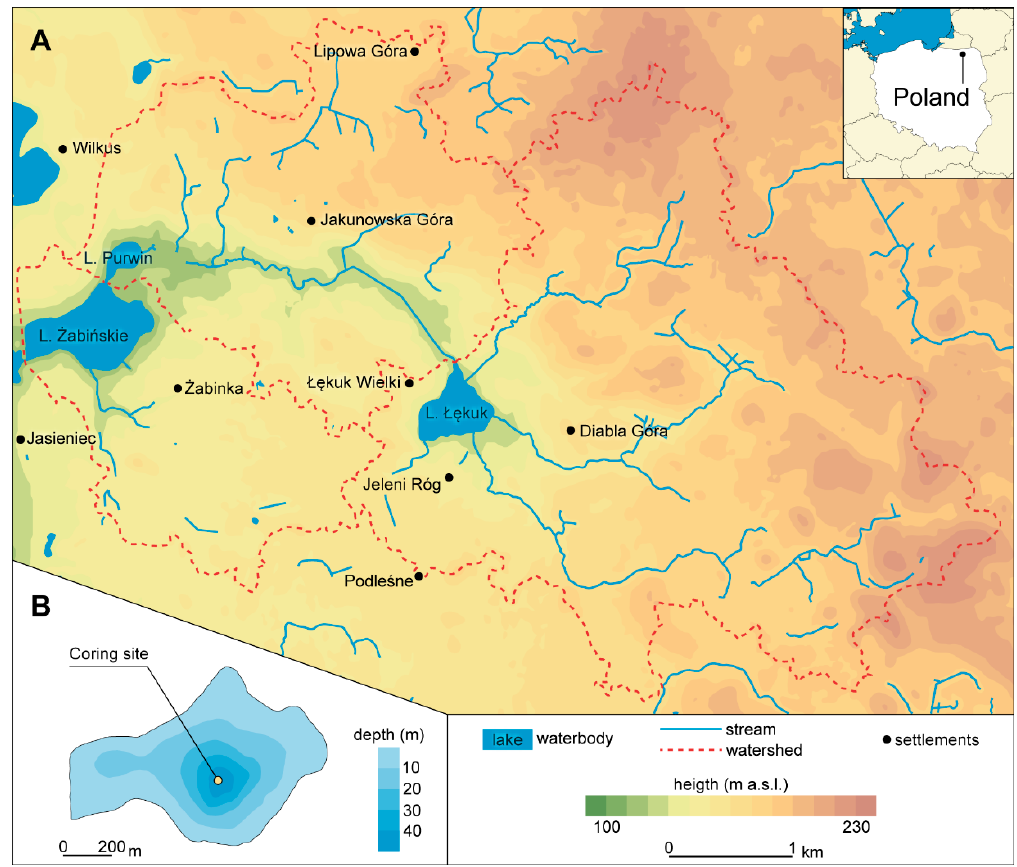
Figure 1. ( a ) Location of Lake Ż abi ń skie. ( b ) Bathymetric map with coring site. Figure 1. ( A ) Location of Lake ˙Zabi´nskie. ( B ) Bathymetric map with coring